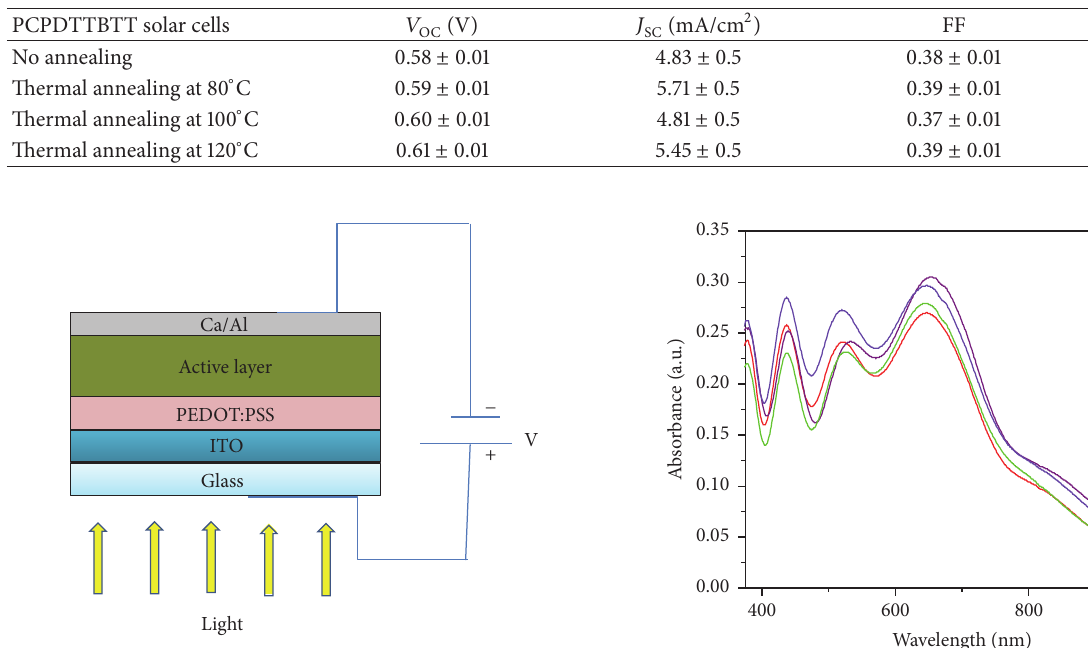
Table 1: Effects of thermal annealing of PCPDTTBTT solar cells on photovoltaic parameters.